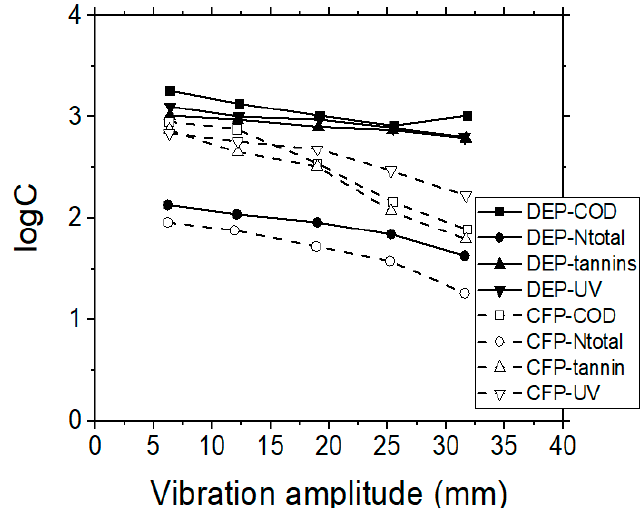
Figure 7. VSEP treatment of simulated tannery wastewaters; the effect of vibration amplitude (mm) on COD, N total , UV 254 nm and tannins residual concentrations, when performing UF membrane experiments, by applying dead-end (DEP), or cross-flow (CFP) operational modes.